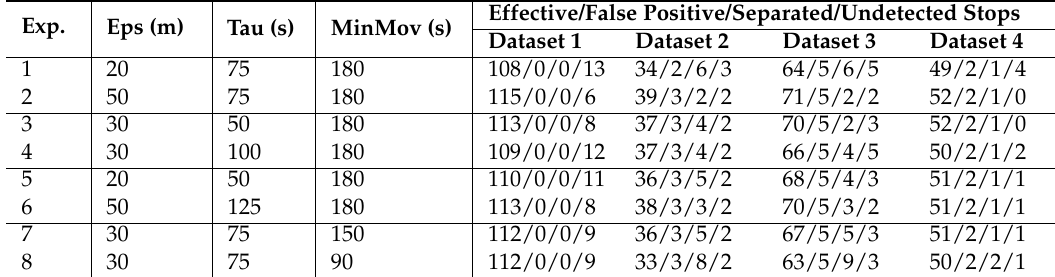
Table 5. The influence of three key parameters on run